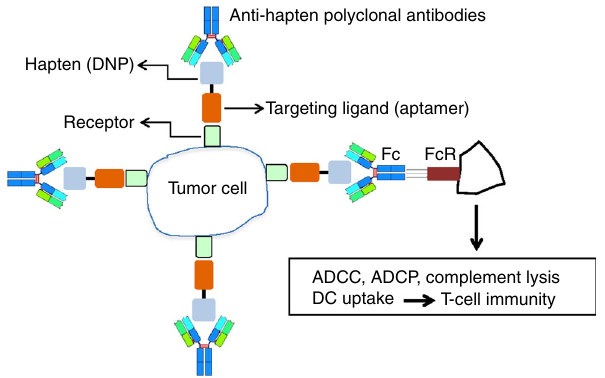
Fig. 1 Coating tumor cells in situ with endogenous polyclonal